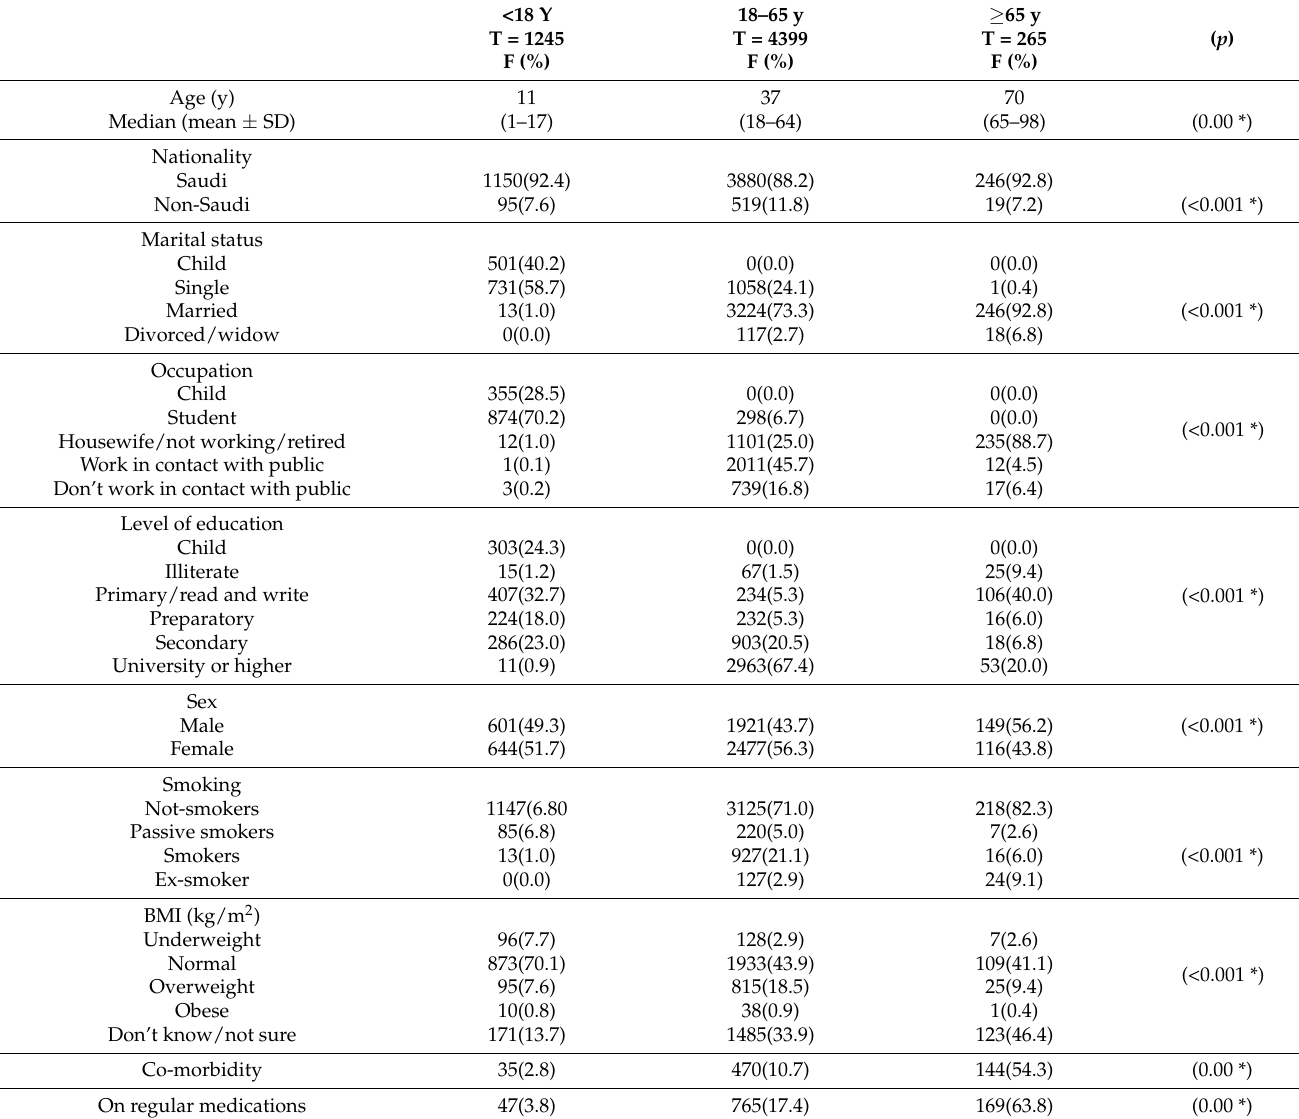
Table 1. Demographic of general characteristics of the COVID-19 participants, and its relationship among different age